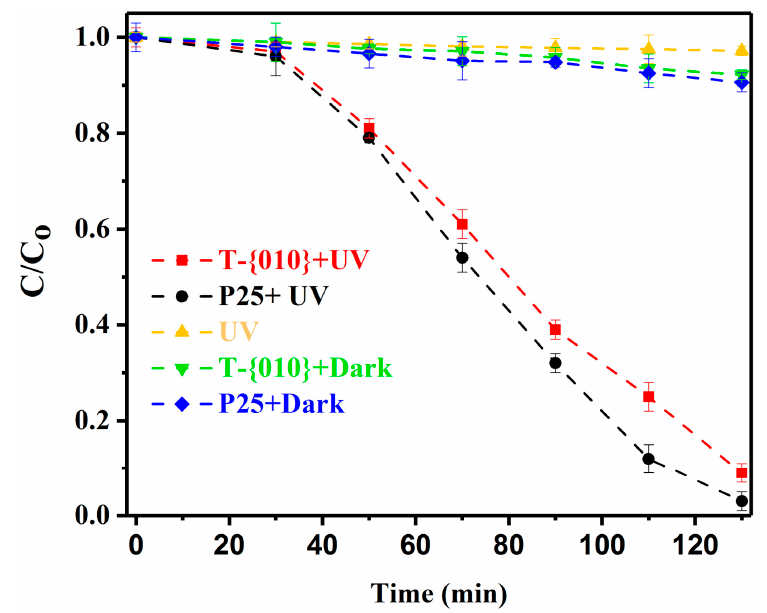
Figure 4. Comparative photocatalytic degradation of Acetaminophen (ACE) under UV light irradiation and dark condition.